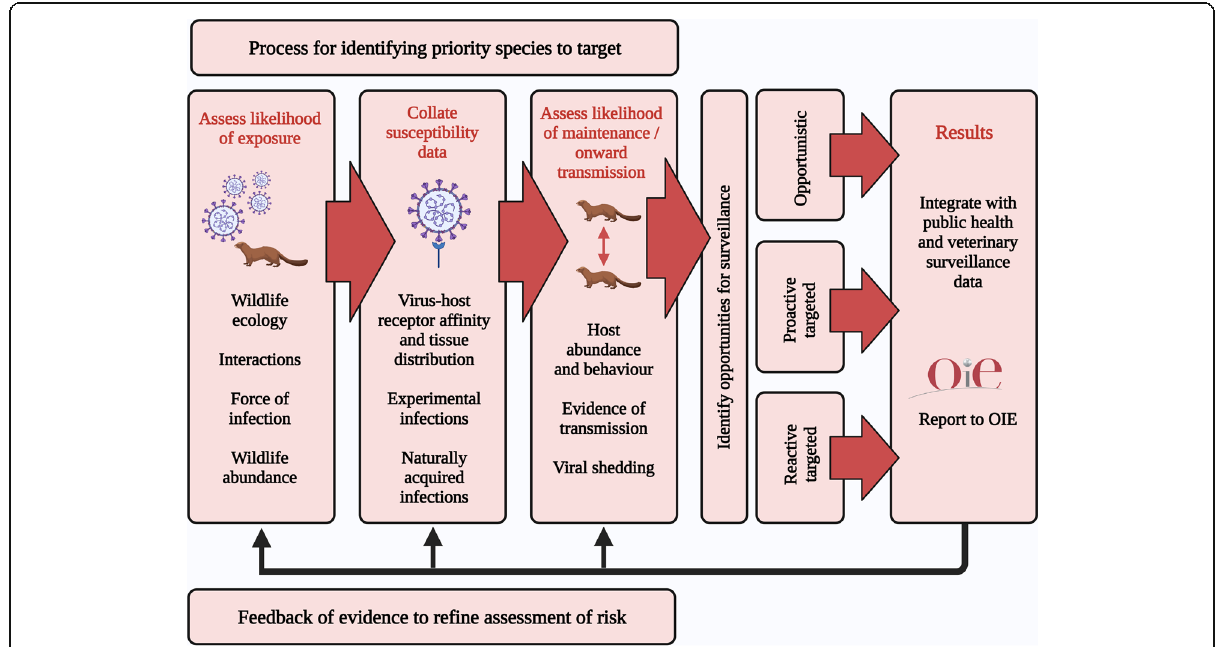
Fig. 2 Conceptual framework for the integration of information to inform surveillance for spill over of SARS-CoV-2 infection from humans to